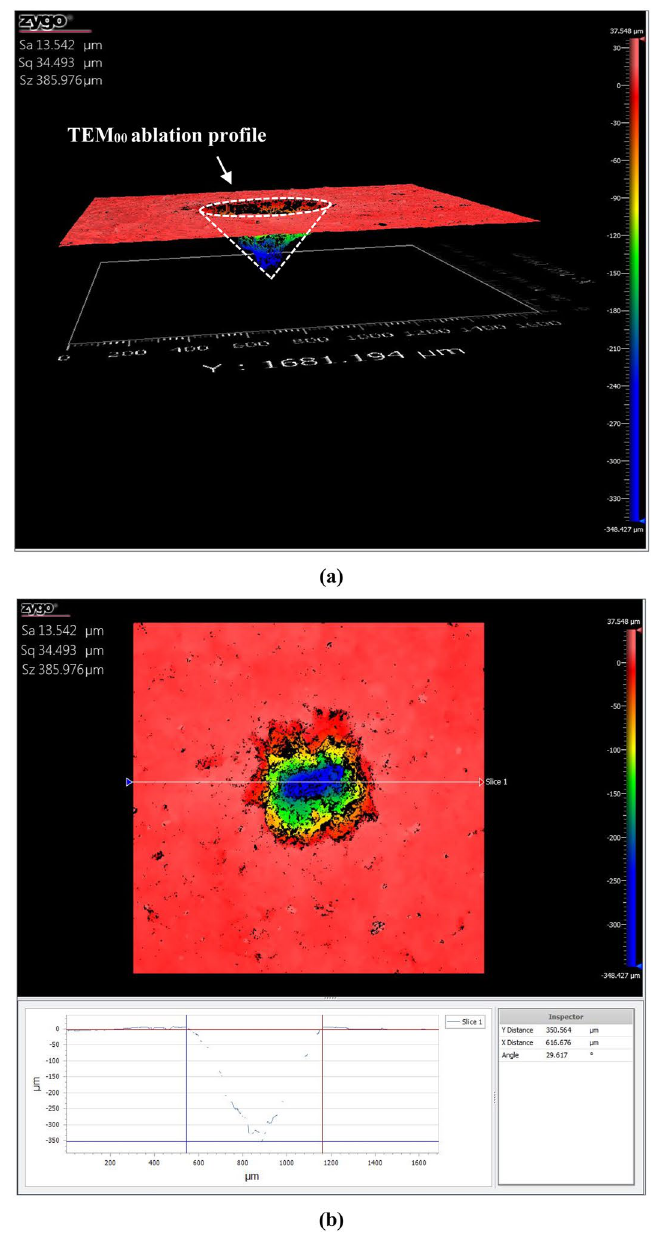
Figure 7. 3D surface profilometer images of coal sample after ablation by fs-Solstice system: ( a ) is the 3D profile and ( b ) is surface profile view. The ablated volume has a circular-cone structure accompanied with absence of molten rims and heat affected zones. The crater diameter is 617 μm and its depth is 350